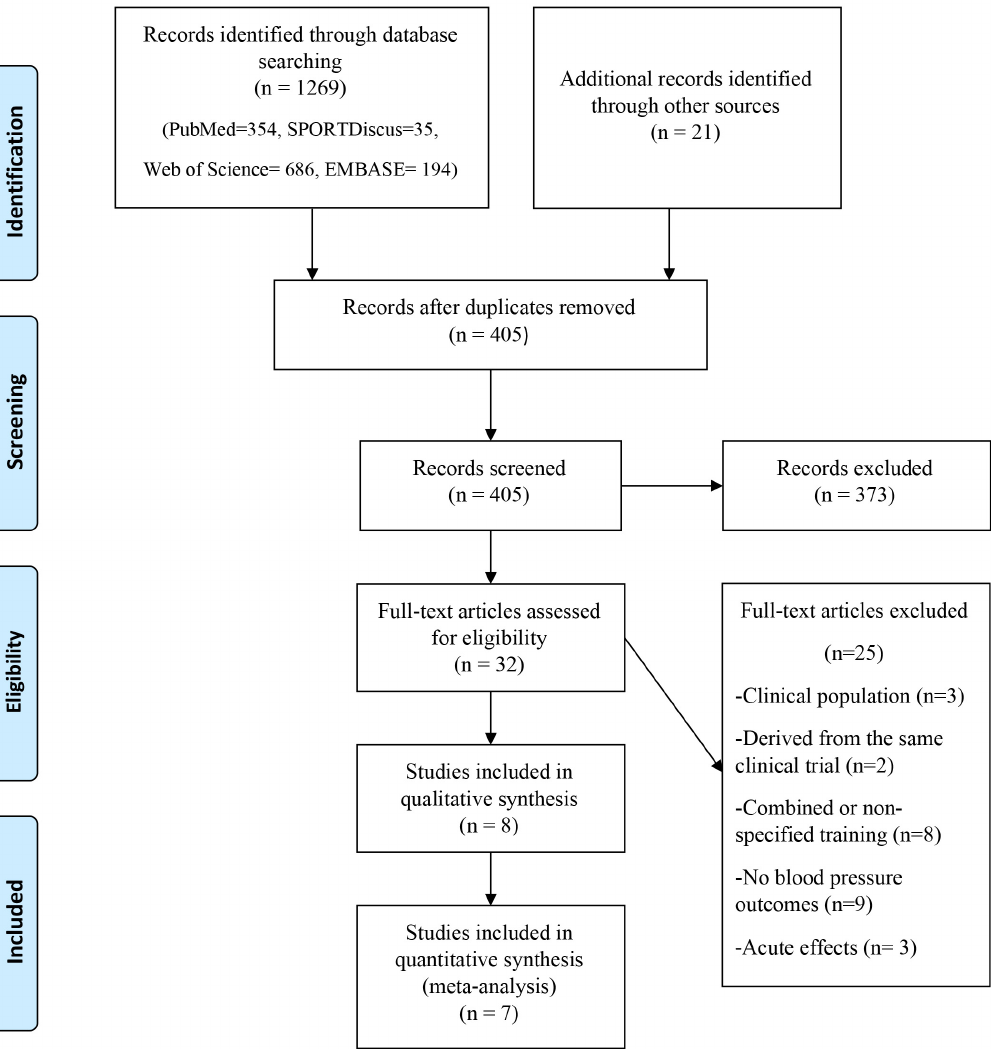
Figure 1. Preferred Reporting Items for Systematic Reviews and Meta-analysis (PRISMA) flow-chart of the study selection .